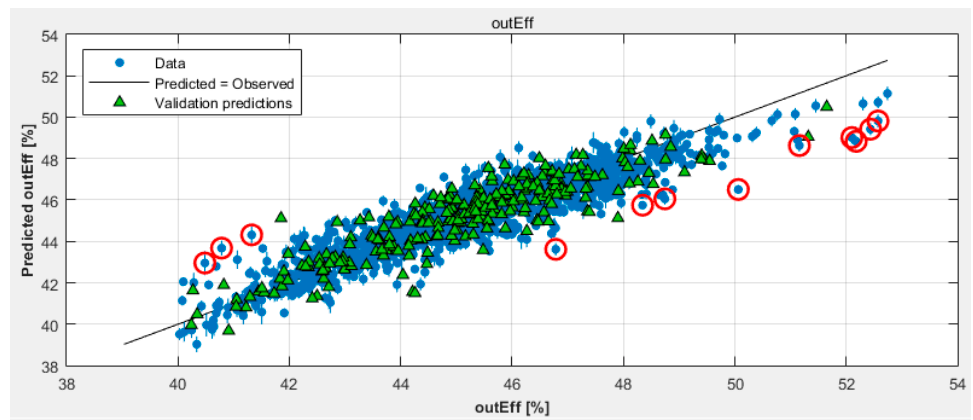
Figure 7. Results of prediction of virtual thermal efficiency based on quadratic function.